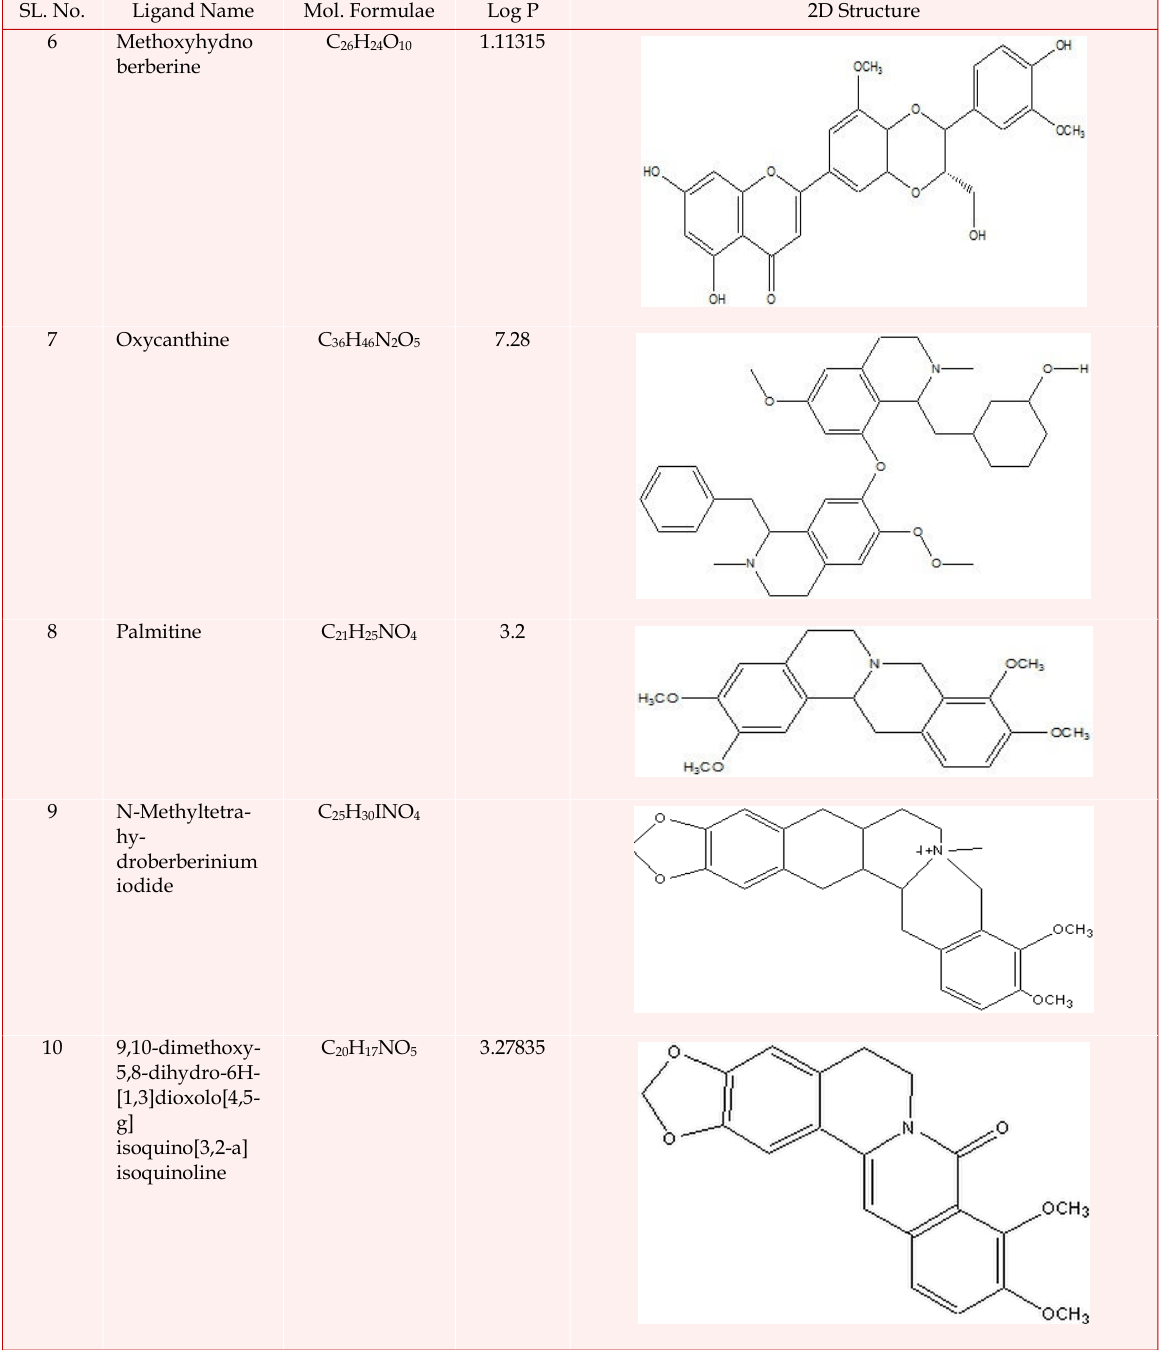
Berberine derivatives along with its chemical properties analyzed using Exome Horizon (Cont.) SL.